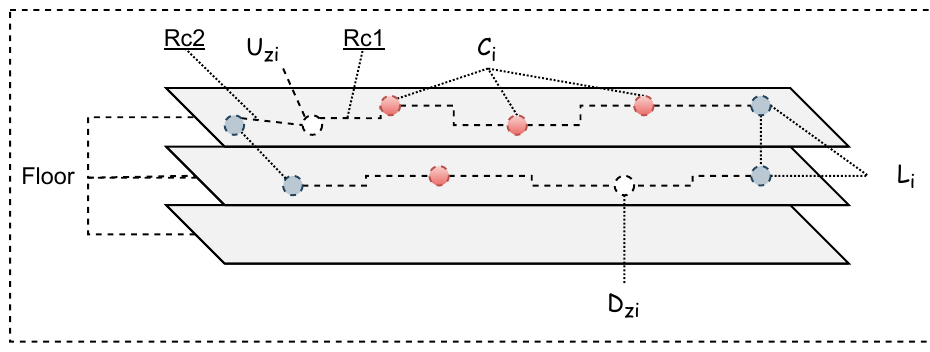
Figure 5. The taxonomy of indoor space ontology.